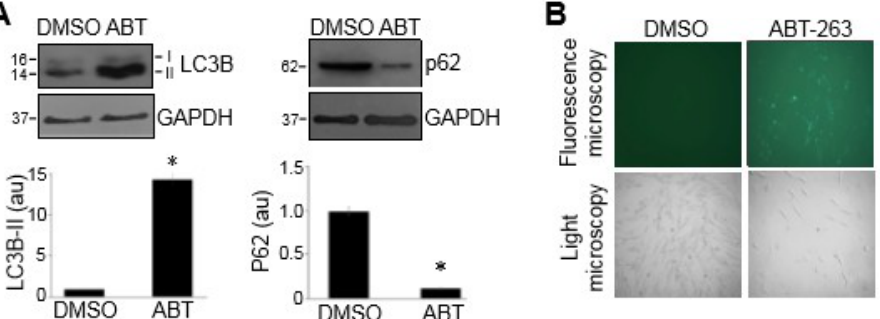
Figure 3. ABT-263 promotes autophagy. Human PASMCs were treated with DMSO (0.1%) or ABT-263 (1 µM) for 24 h. ( A ) Cell lysates were subjected to Western blotting to monitor the LC3B-II and p62 levels. The bar graph represents the mean ± standard error of the mean (SEM) of the protein levels determined by densitometry expressed in an arbitrary unit (au). * denotes that the value was significantly different from the DMSO control at p < 0.05 (n = 3). ( B ) Autophagy was assessed by the detection of autophagic vacuoles with a green fluorescent compound that was incorporated into multilamellar bodies.